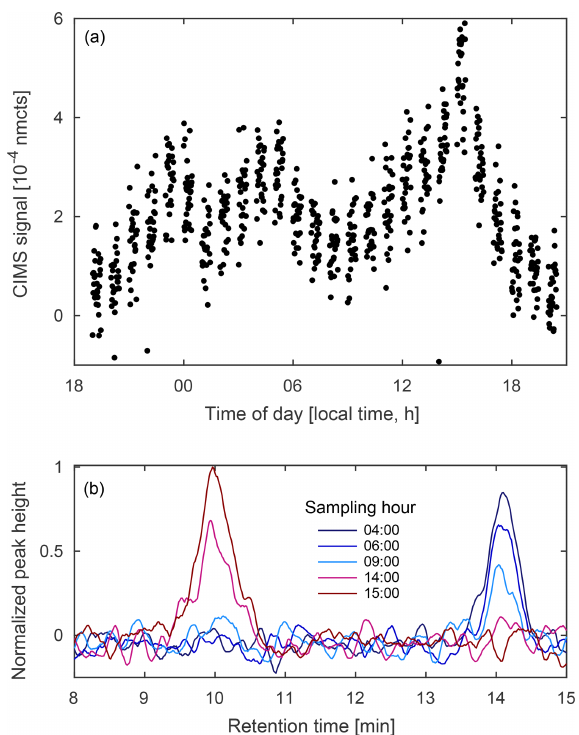
Figure 13. (a) Diurnal profile of unidentified compounds observed at m/z 236 (MW151) from 11 to 12 August 2017 during the Cal- tech field study and (b) select field chromatograms from the same sampling period. The GC shows at least two compounds contribute to the signal, one more abundant at night (blue) and the other more abundant in the late afternoon (red).